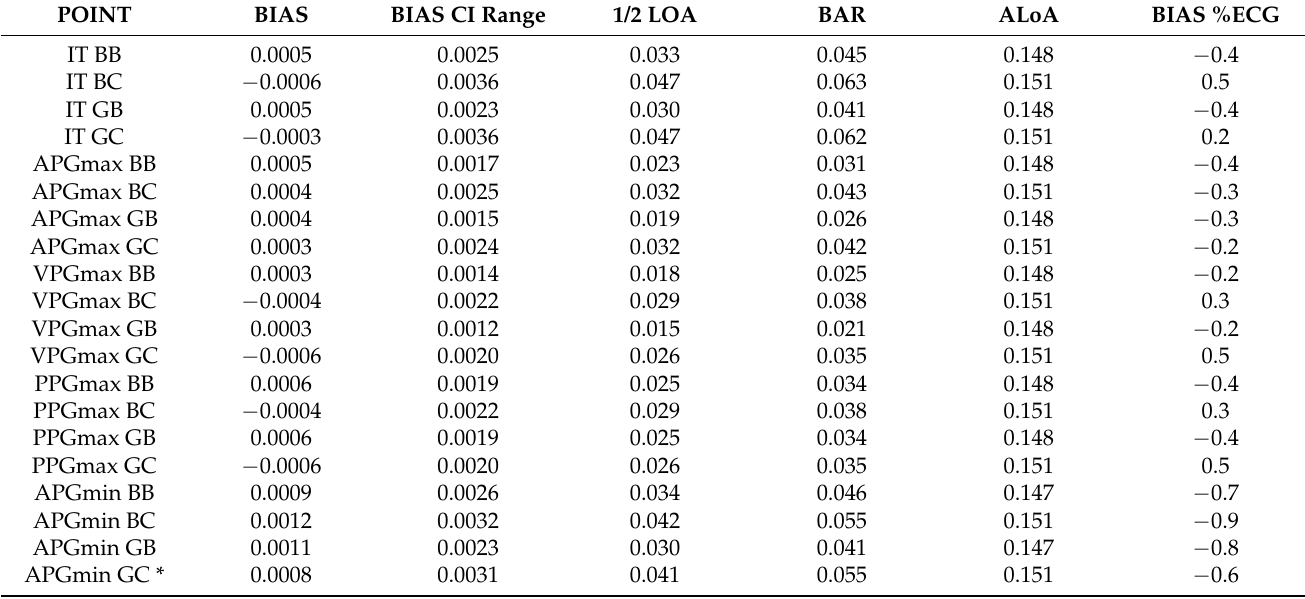
Table 1. Bland-Altman analysis results of 720 ECG-PPG data pairs from 12